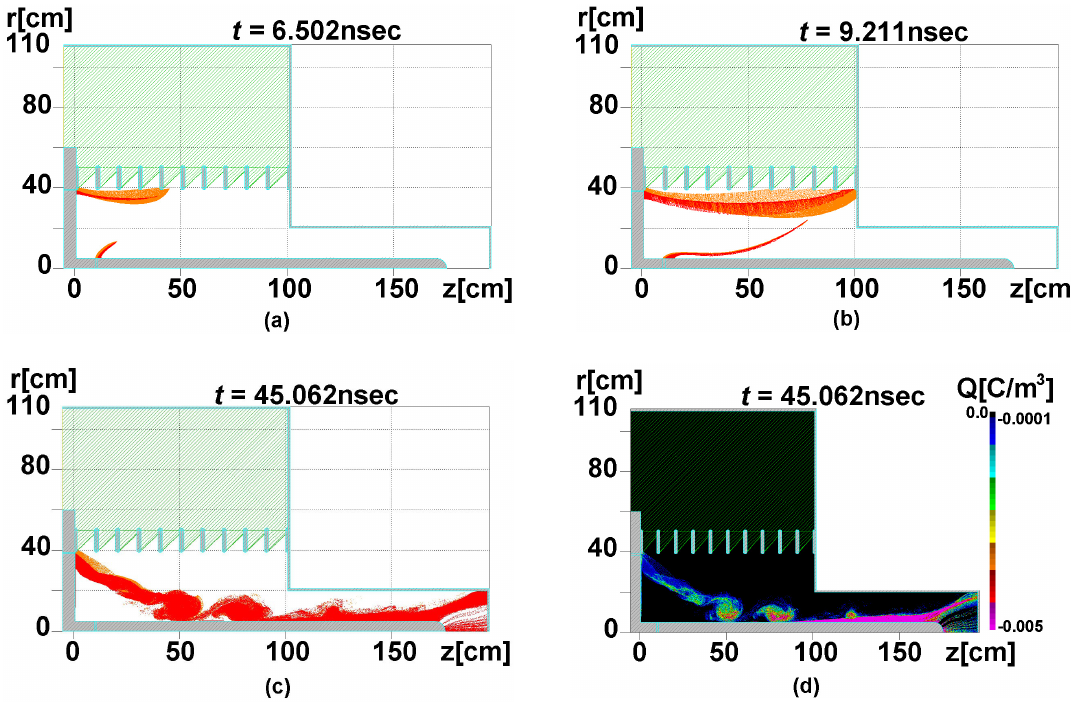
FIG. 11. (Color) Same as Fig. 10 with a stack replacing the monolithic insulator for t (cid:5) 6 : 502 (a), 9.211 (b), 45.602 (c) nsec, and charge density contours in (d) at 45.062